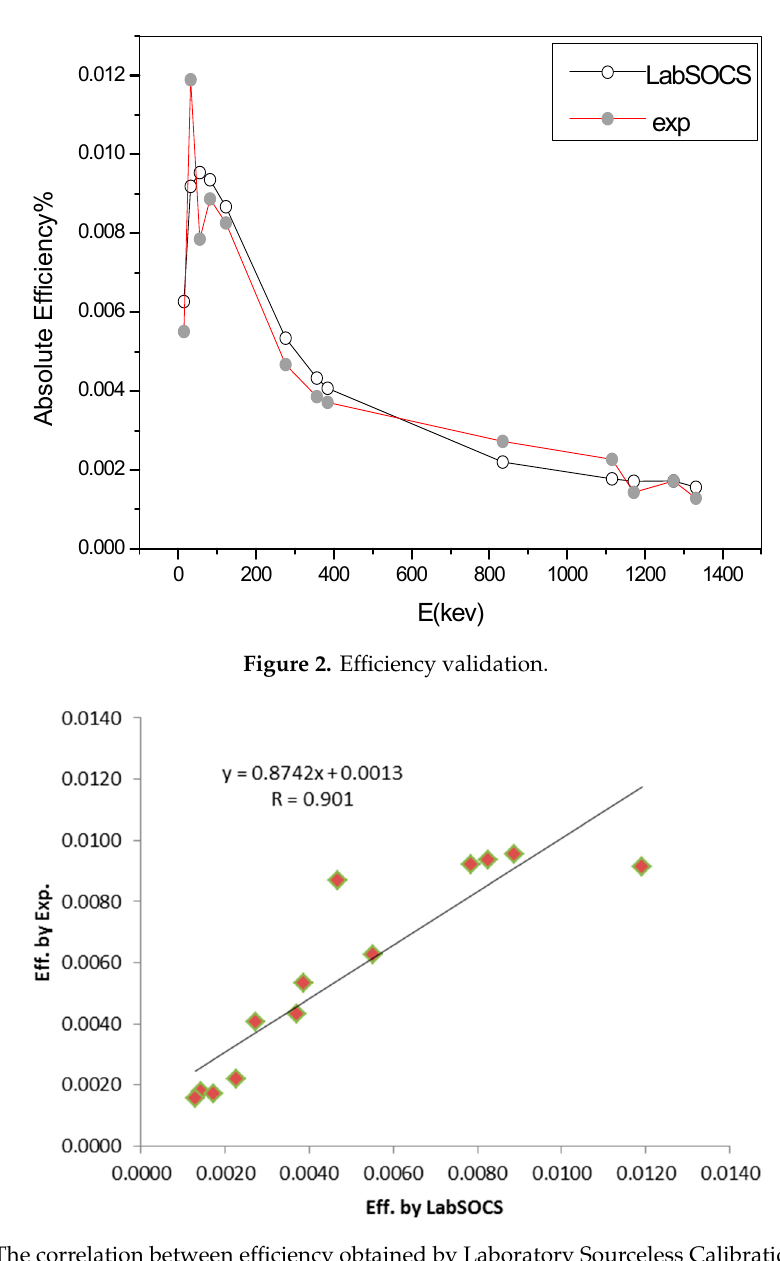
Figure 3. The correlation between efficiency obtained by Laboratory Sourceless Calibration Software (LABSOCS) and our experiment.